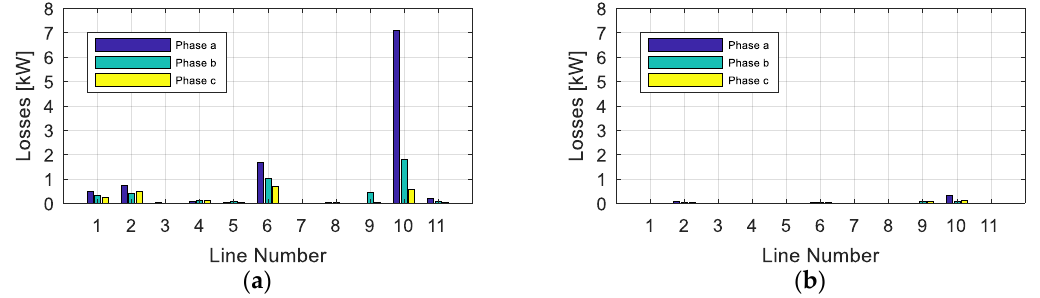
Figure 10 . Scenario 1: Line losses at the hours: ( a ) Peak-H and ( b ) Peak-L.